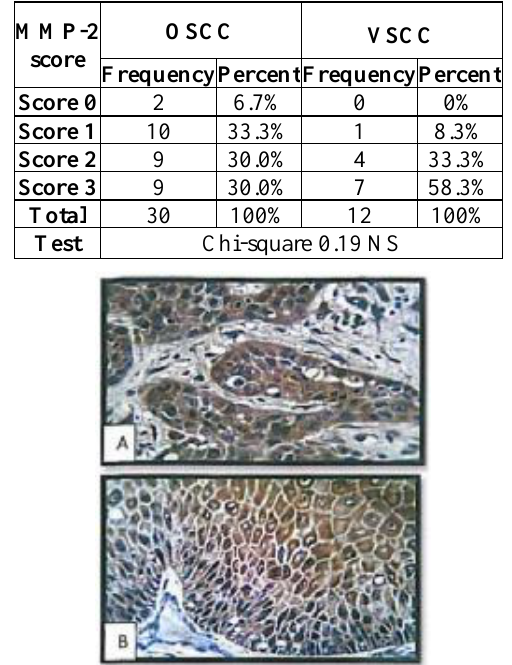
Table 1: MMP-2 scores in OSCC and VSCC